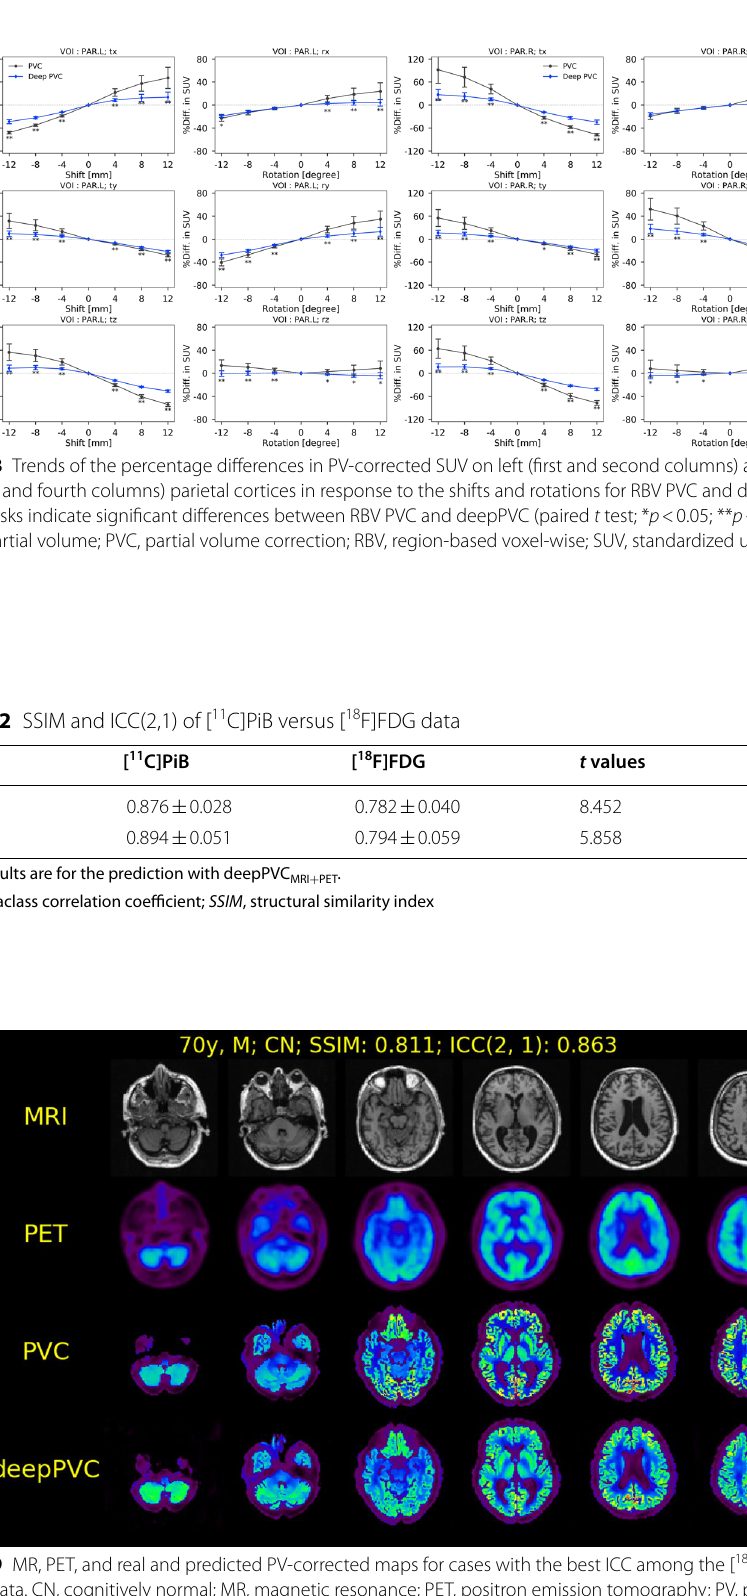
Fig. 9 MR, PET, and real and predicted PV-corrected maps for cases with the best ICC among the [ 18 F]FDG test data. CN, cognitively normal; MR, magnetic resonance; PET, positron emission tomography; PV, partial